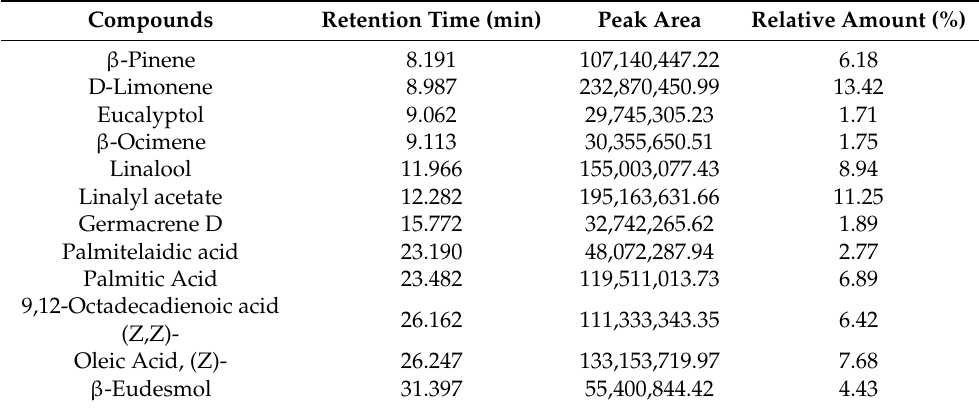
Table 1, different monoterpenes, sesquiterpenes, and fatty acids were identified. The predominant compounds were D-limonene (13.42%), linalyl acetate (11.25%), and linalool (8.94%) in ZBEO obtained by supercritical CO 2 fluid extraction. Other major compounds were β -pinene (6.18%), palmitic acid (6.89%), 9,12-octadecadienoic acid (Z,Z)-(6.42%), and oleic acid, (Z)-(7.68%). In previous studies, the predominance of the same compounds was reported but with differences in the quantitative profile [21,27,28]. Moreover, ZBEO was also found to contain various saturated and unsaturated fatty acids [20]. The chemical compositions and proportions of EO is highly influenced by the cultivar, geographic region, plant tissue, and extraction method [21,29]. Table 1. The chemical compositions (more than 1% of the total oil) identified in ZBEO using GC-MS